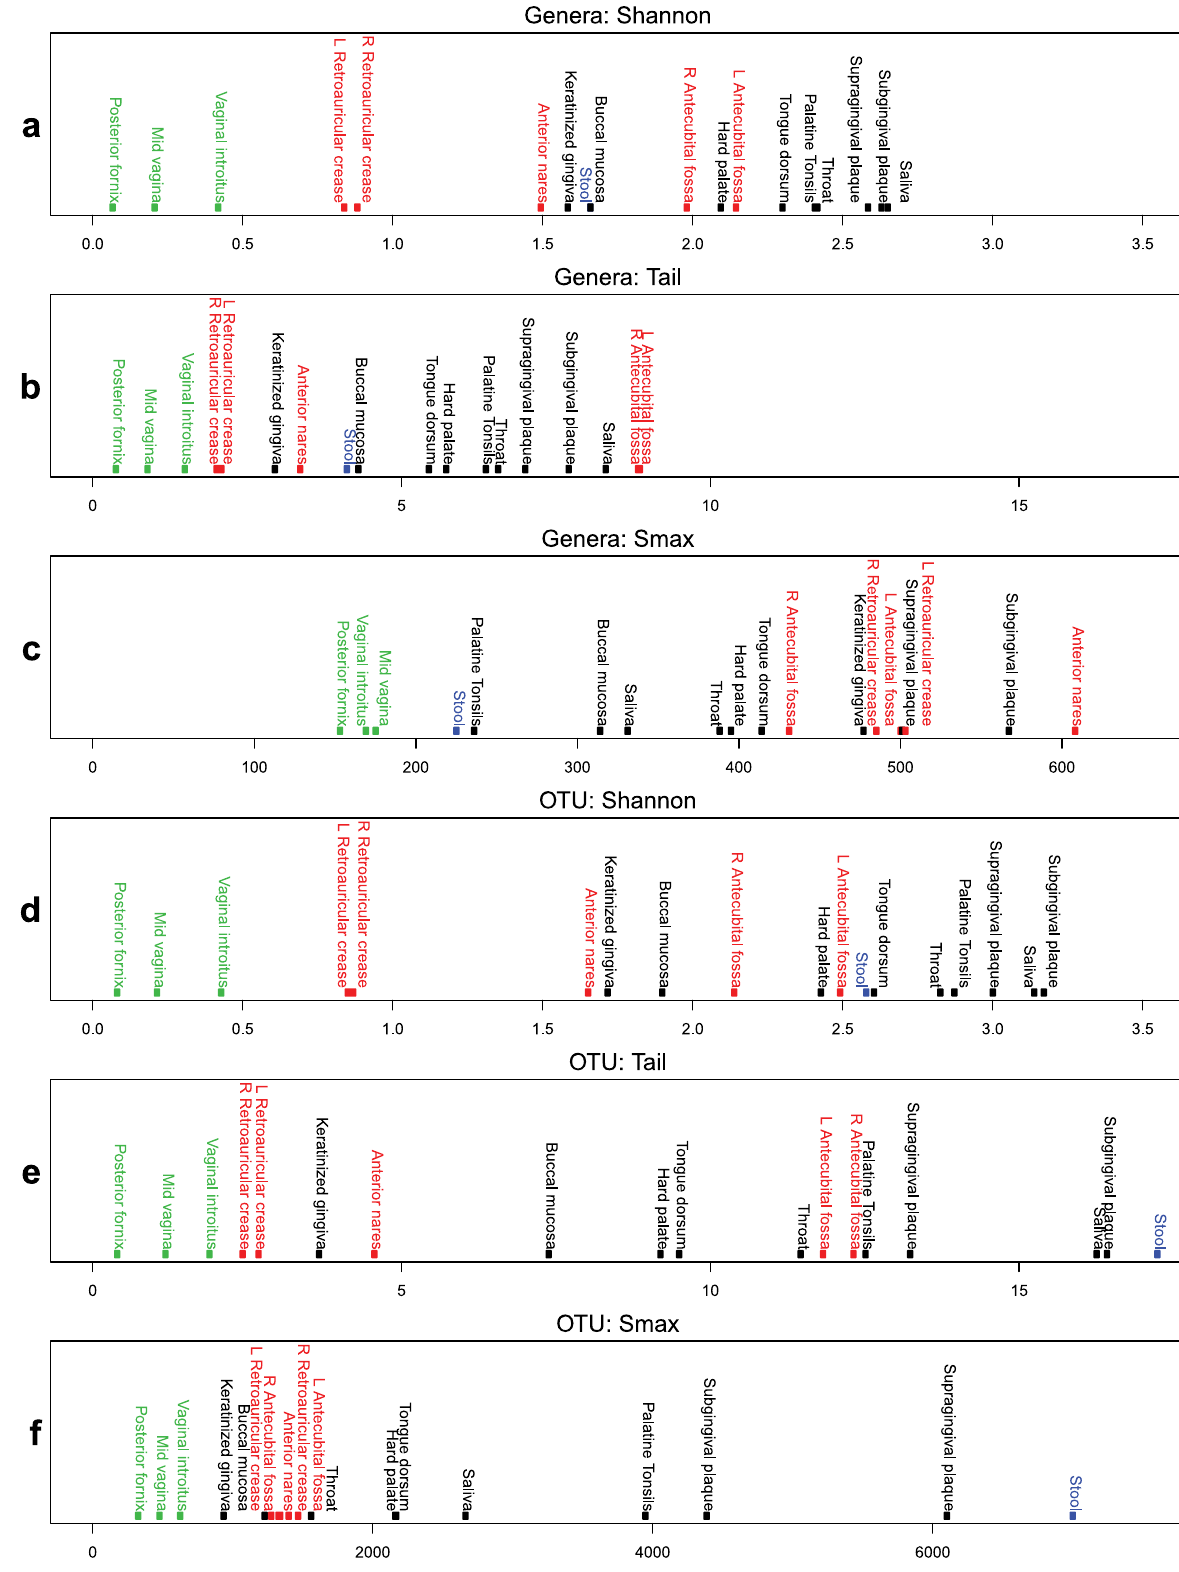
Figure 2. Body habitats ordered by diversity measure. Body regions are color coded, Oral-black, Skin-red, Vaginal-green, and Stool-blue. Subfigures a, b, and c, were computed on genera-based taxonomic units. Subfigures d, e, and f, were computed on OTU-based taxonomic units.